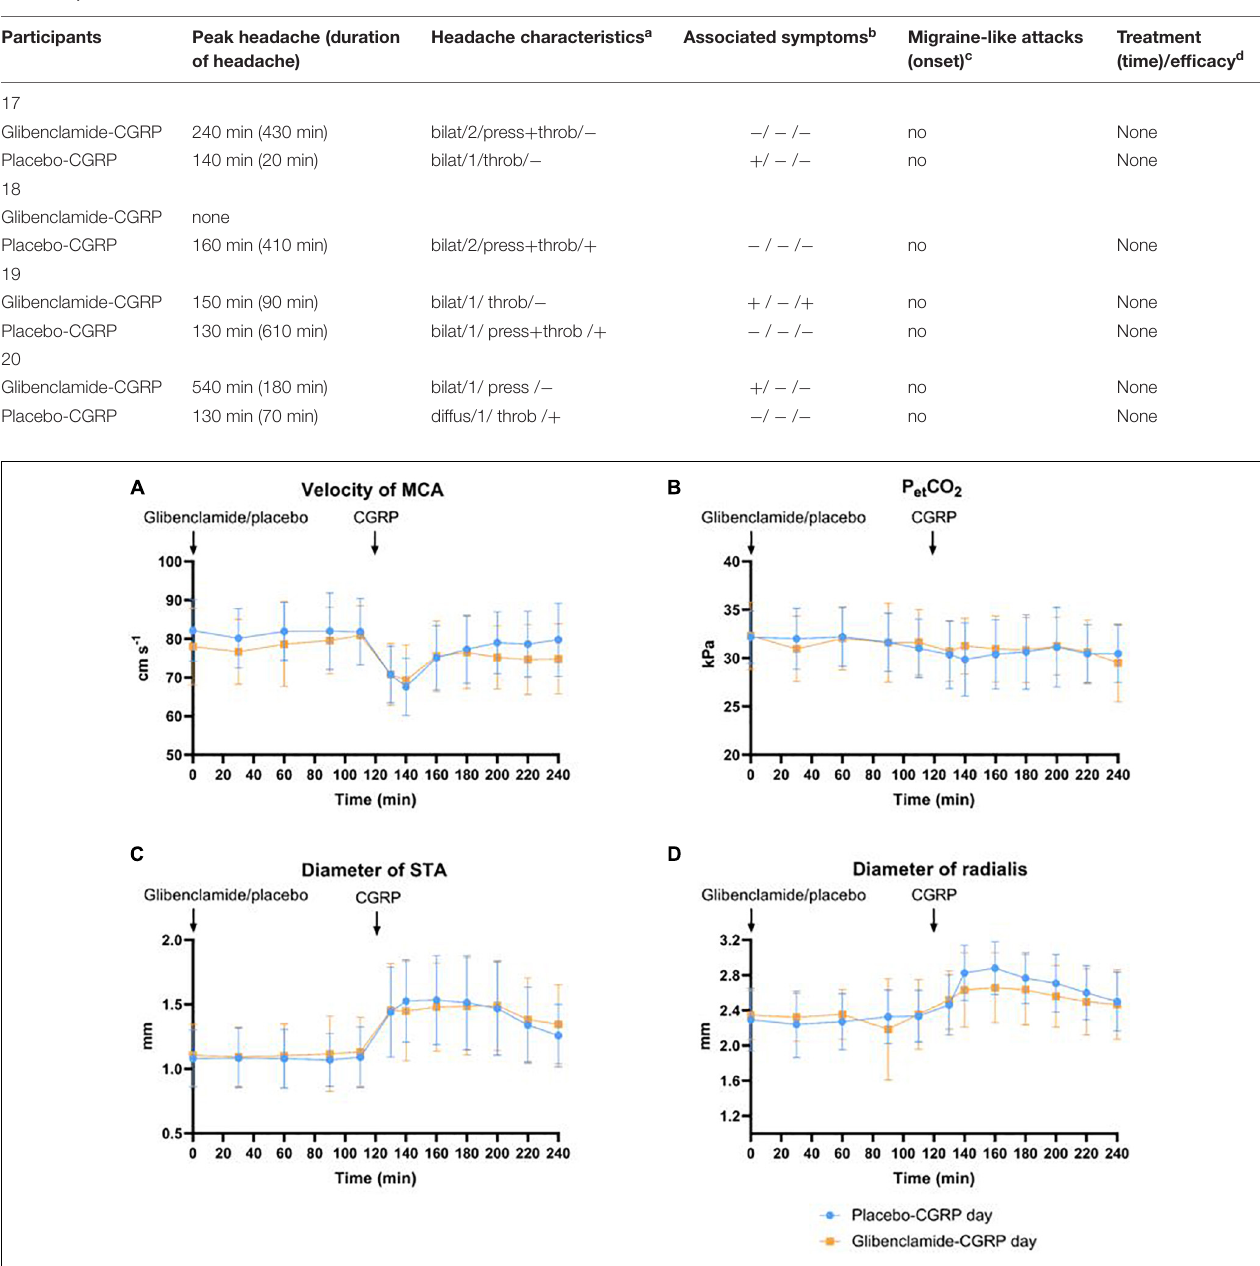
FIGURE 4 | (A) Effect of glibenclamide and placebo on middle cerebral artery (MCA) as changes in velocity (cm/s), n = 20. There was no difference in AUC 0 − 240 min for V MCA between glibenclamide-CGRP and placebo-CGRP day. (B) Changes in end-tidal pCO 2 were monitored during MCA-measurements. There was no difference in changes in end-tidal PCO 2 (PetCO 2 ) between two experimental days. (C) Changes in superficial temporal artery (STA) in diameter (mm). There was no difference in AUC 0 − 240 min for STA between glibenclamide-CGRP and placebo-CGRP day. (D) Changes in radial artery (RA) diameter (mm). No changes in AUC 0 − 240 min for RA diameter was observed between glibenclamide-CGRP and placebo-CGRP